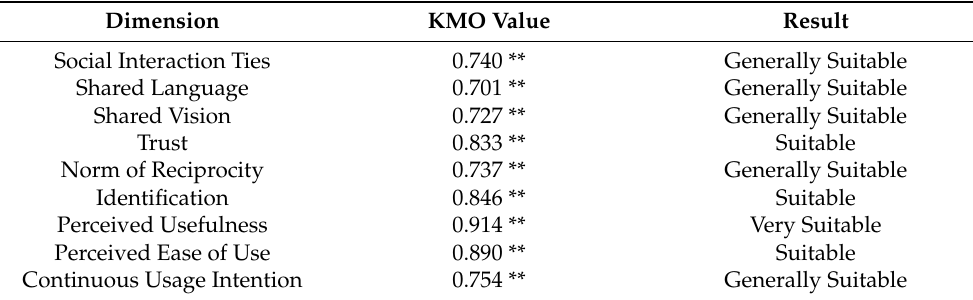
Table 6. The KMO spherical test